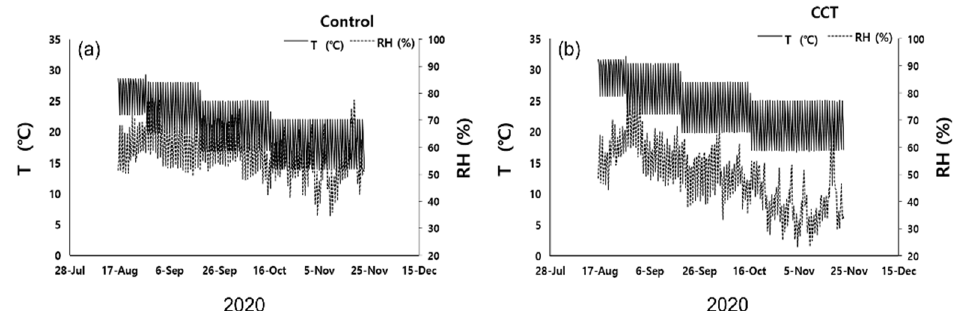
Figure 1. Changes of temperature (T) and relative humidity (RH) of Sedirea japonica under control (CO 2 = 400 ppm) ( a ) and CCT (climate change treatment, CO 2 = 650 ppm, temperature = control + 3 °C) ( b ) during the experimental period.